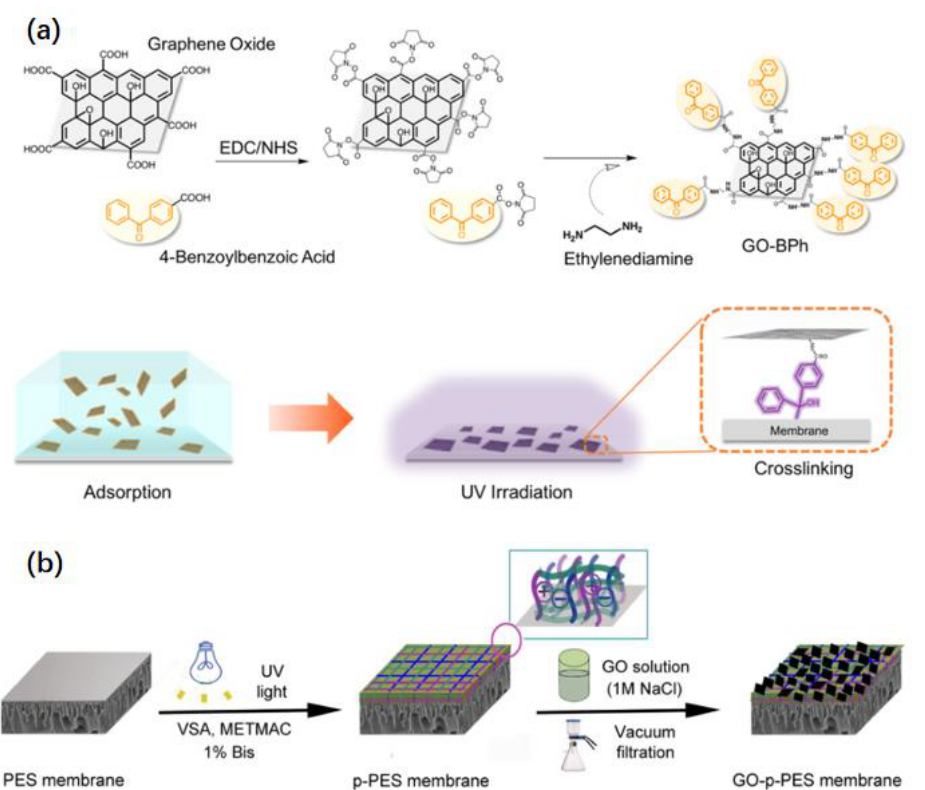
Figure 3. ( a ) Schematic diagram of the chemical surface modification process of benzophenone. (Printed image with permission from Ref. [74], copyright 2019, American Chemistry Society). ( b ) Schematic illustration of the two-step synthesis process of GO functionalized zwitterionic polyam- pholyte hydrogel polyethersulfone (PES) membrane. (Printed image with permission from Ref. [76], copyright 2018, Elsevier Ltd.).